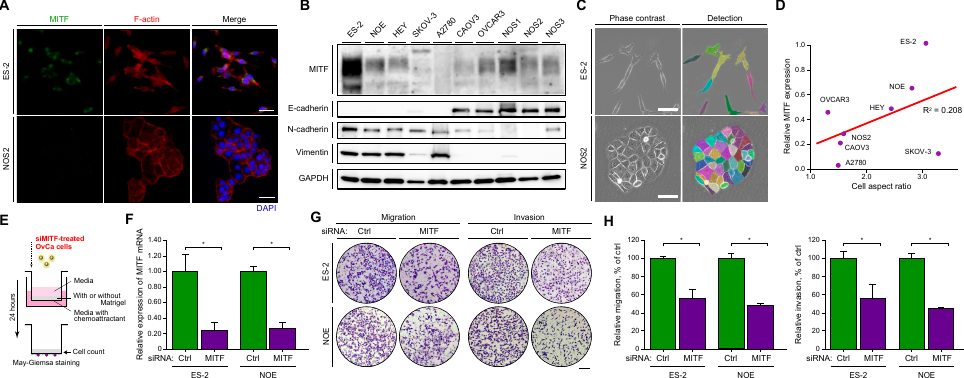
Figure 2. MITF expression is associated with motility and invasion of OvCa cells. ( A ) Representative images of immunofluorescence detecting MITF (left panels) and F - actin (middle panels) in ES - 2 and NOS2 cells. Scale bar: 50 μ m. ( B ) Immunoblots of MITF, E - cadherin, N - cadherin, vimentin, and GAPDH with proteins extracted from OvCa cell lines. ( C ) Images of the cell aspect ratios in OvCa cells. Scale bar: 50 μ m. ( D ) Correlation of MITF expression levels with the immunoblot results and cell aspect ratio of each OvCa cell line. ( E ) Schematic protocol for the motility and invasion assay. ( F ) Relative expression levels of MITF mRNA in ES - 2 and NOE cells under siRNA treatment. * p < 0.05 ( t - test). ( G ) Representative images in the motility and invasion assays. Scale bar: 200 μ m. ( H ) Relative migration and invasion percentages in ES - 2 and NOE cells under siRNA treatment. * p < 0.05 ( t - test).